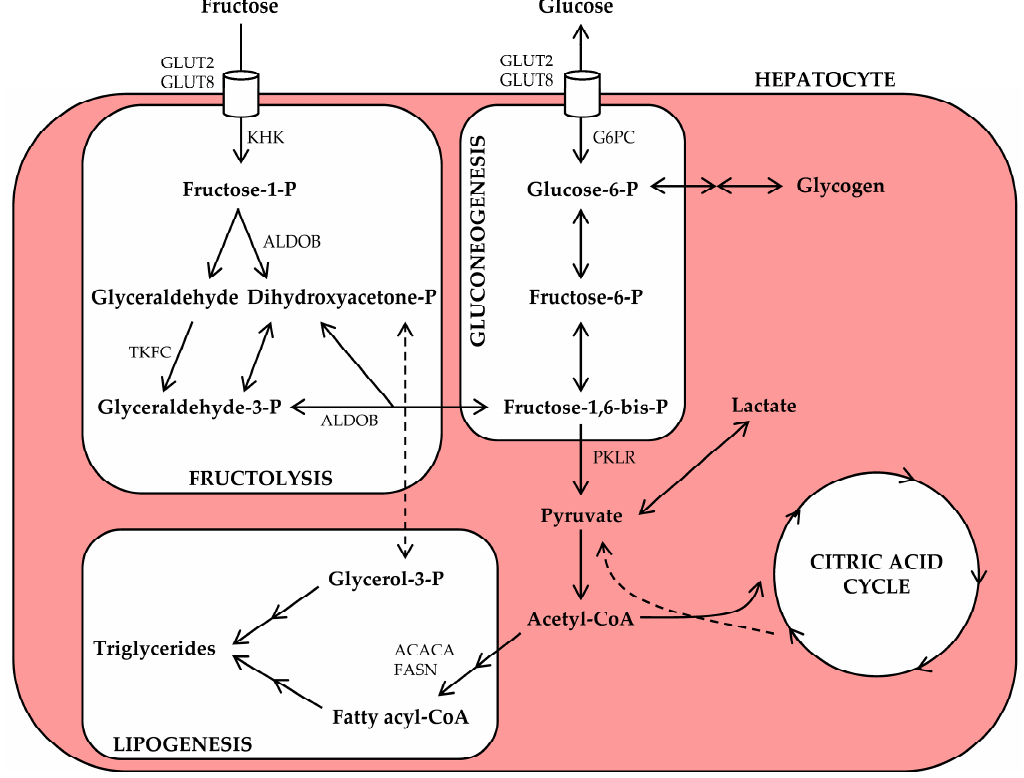
Figure 1. Hepatic fructose metabolism provides substrate for multiple metabolic pathways. Ingested fructose is transported from the portal vein into hepatocytes via glucose transporter 2 (GLUT2) and glucose transporter 8 (GLUT8). Ketohexokinase (KHK) converts intracellular fructose to fructose-1-phosphate (fructose-1-P), which is then split into glyceraldehyde and dihydroxyacetone-phosphate (dihydroxyacetone-P) by aldolase B (ALDOB). Glyceraldehyde is further phosphorylated to glyceraldehyde-3-phosphate (glyceraldehyde-3-P). Fructolysis-derived triose phosphates can now be used for gluconeogenesis, glycogen synthesis, lactate production, or acetyl-CoA production, and the latter can be oxidized or used for lipogenesis. Other abbreviations: ACACA, acetyl-CoA carboxylase α ; FASN, fatty acid synthase; G6PC, glucose-6-phosphatase; P, phosphate; PKLR, pyruvate kinase; TKFC, triokinase.